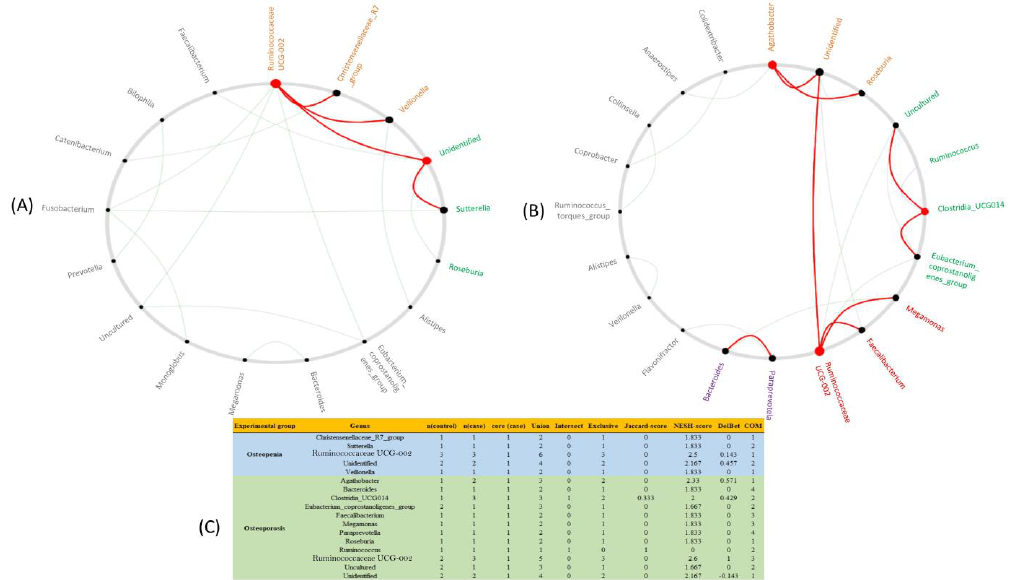
( B ) groups. The red color nodes denote the driver genera identified using the NetShift technique. The node sizes represent the NESH scores, and the characteristics of these nodes between osteopenia and osteoporosis groups are provided in table ( C